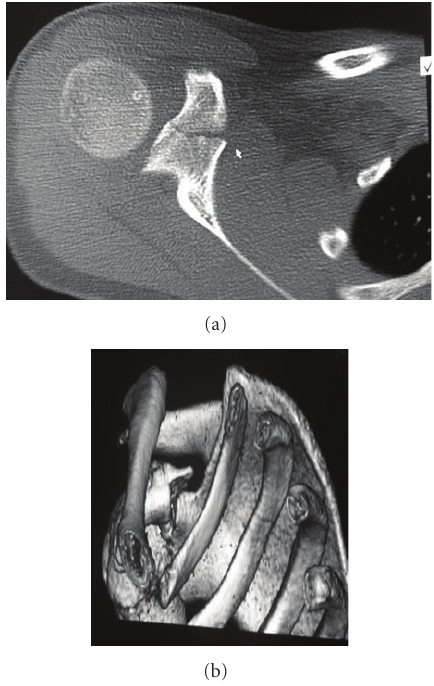
Figure 5: Case B: axial CT scan and CT 3D reconstruction.